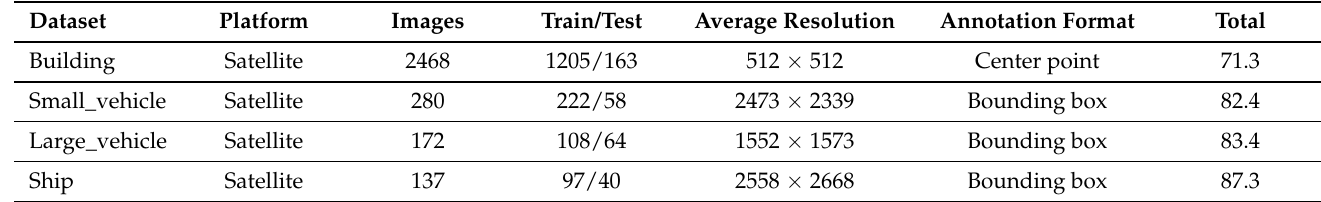
Table 1. Relevant statistics for the four sub-datasets of the RSOC